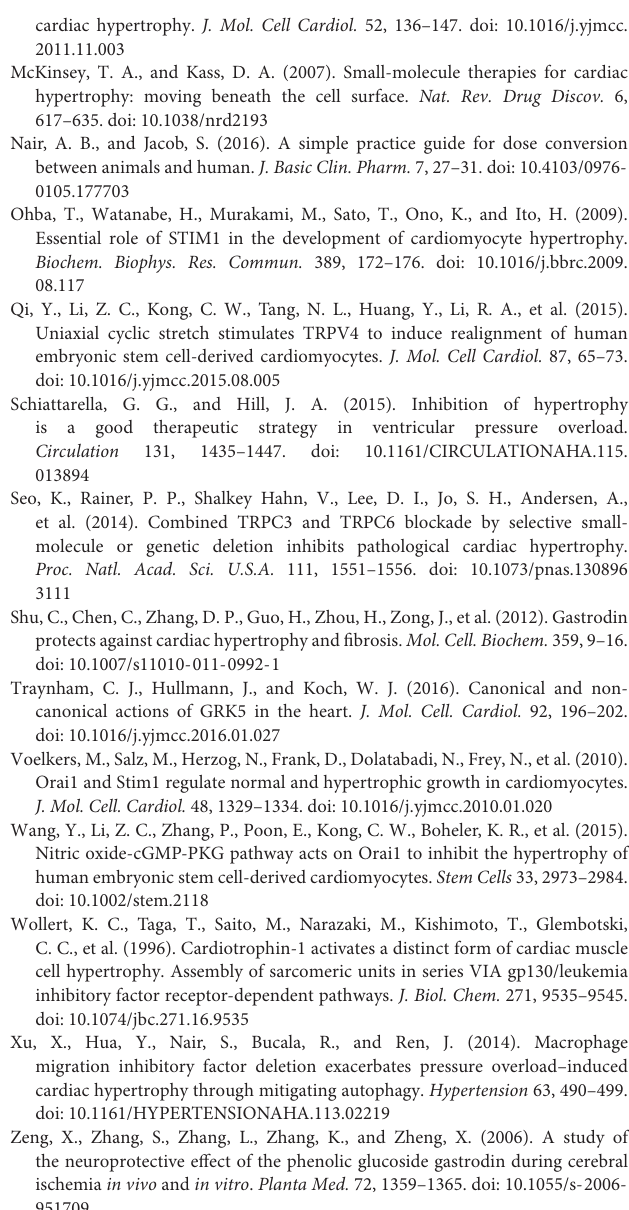
FIGURE S2 | Lack of gastrodin effect on the contractile responses of mouse aortas to PE, Ang-II and endothelin-1. Shown are representative traces (left) and data summary (right). If needed, the aortas were pretreated with 100 µ mol/L gastrodin for 10 min before application of (A) phenylephrine (PE, 1 µ mol/L), (B) angiotensin II (Ang-II, 50 nmol/L) or (C) endothelin-1 (ET-1, 50 nmol/L). The magnitude of contraction was normalized to the percentage of contraction in response to 60 mmol K + . The data are expressed as the mean ± SEM ( n = 5–6 repeats). ns, not